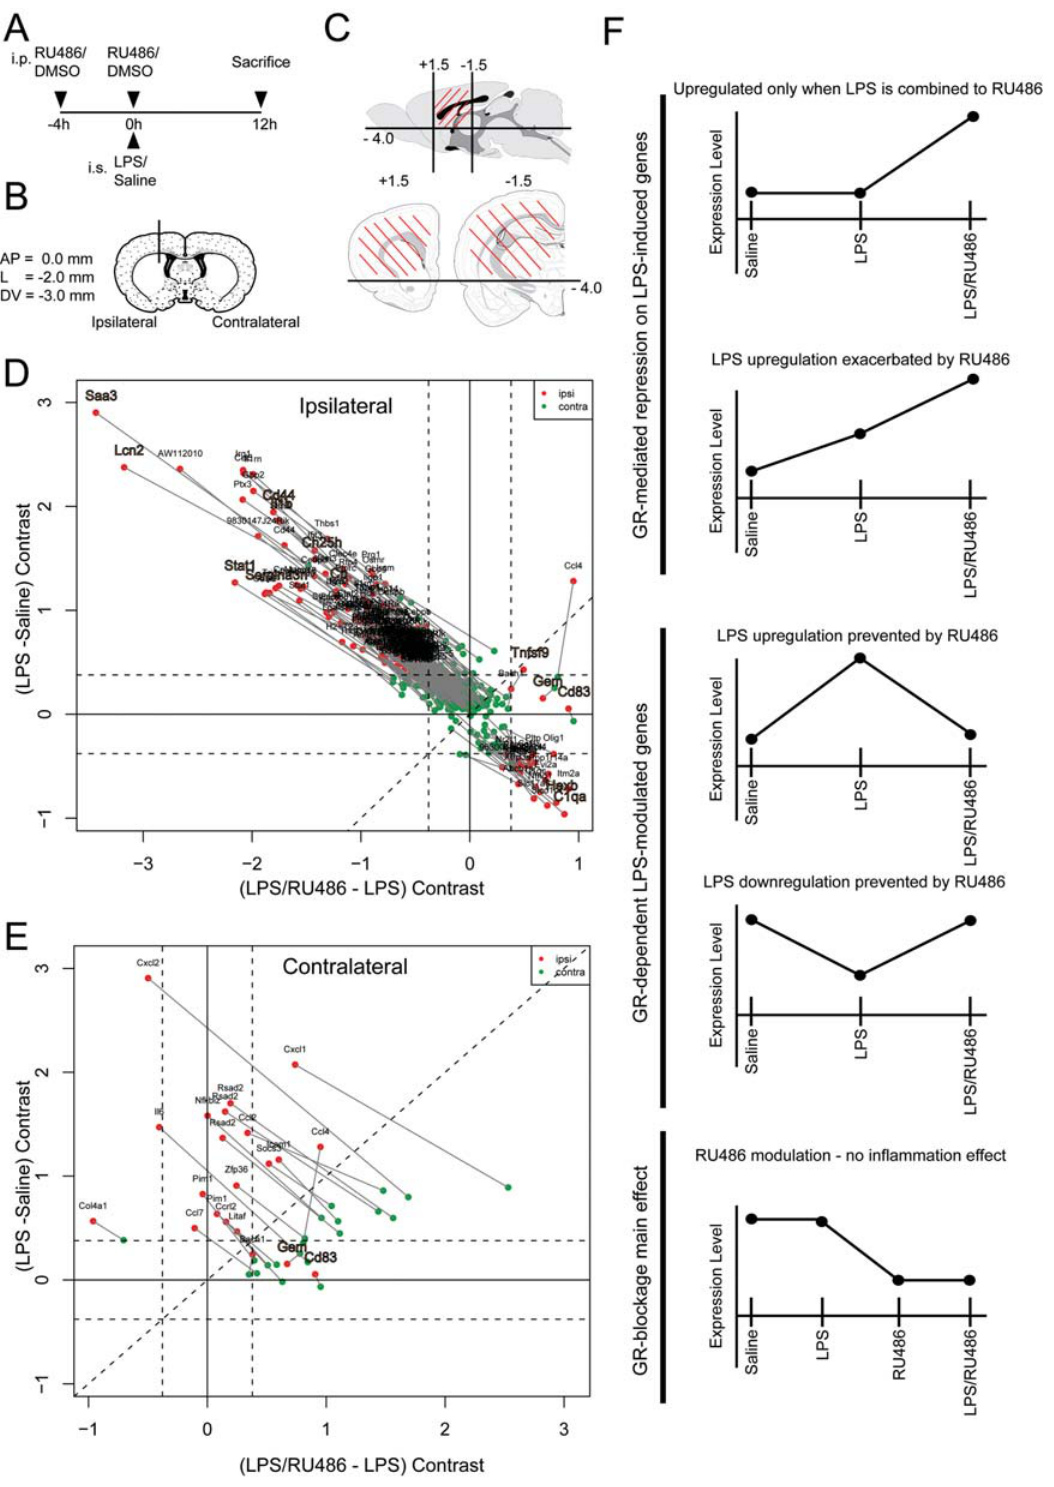
Figure 1. Gene profiling of CNS LPS response in presence or absence of functional GR signaling. (A) Treatment schedule of animals. (B and C) Schematic representation of the injection site and brain area dissected for RNA isolation, respectively. (D) A 2-contrast plot of genes selected as differently expressed in ipsilateral side when LPS injection was performed in mice pre-treated or not with RU486. The abscissa axis represents the difference (contrast) between LPS/RU486 treatment and LPS single treatment (RMA expression levels); ordinate axis represents the LPS vs . Saline contrast. Red dots represent ipsilateral contrast value; green dots, represent contralateral contrast values. Genes highlighted in the diagram were selected for validation experiments. Dashed lines: 30% fold-change. (E) Similar to ‘‘D’’, but in regard to contralateral side. (F) Representation of the gene expression behavior associated with RU486 effects on LPS-induced changes, defining how these groups of genes are described in the text. Abbreviations: AP, antero-posterior; contra, contralateral; DV, dorso-ventral; i.p., intra-peritoneal; ipsi, ipsilateral; i.s., intrastriatal; L, lateral.